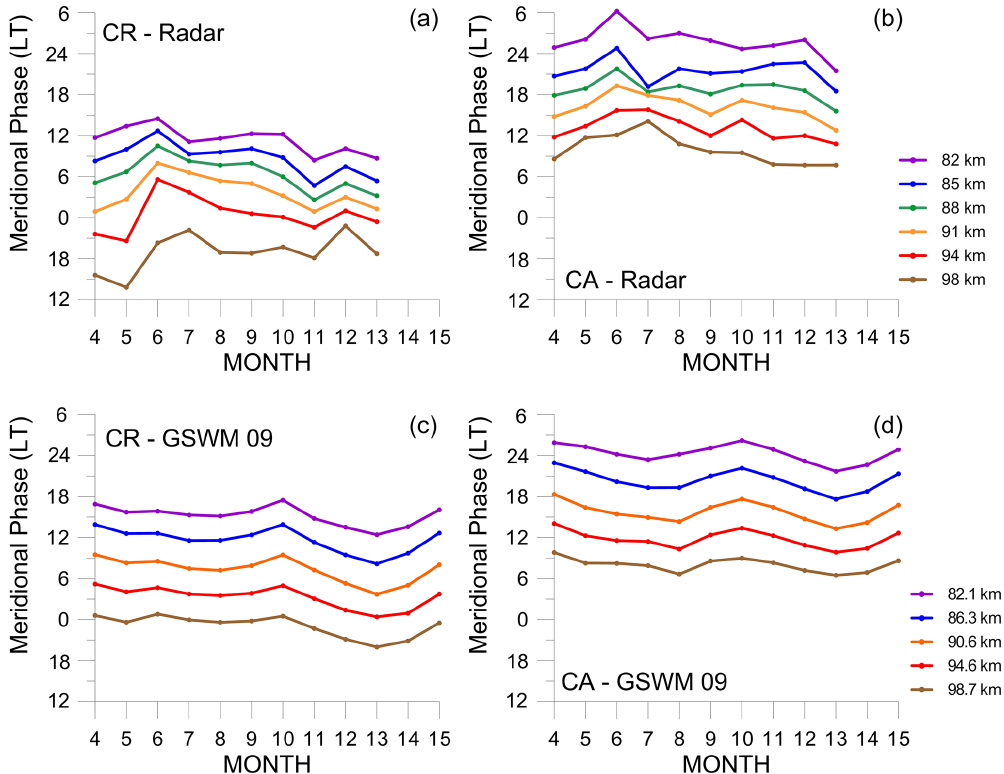
Figure 6. Meridional diurnal phase in LT for CR (a) and CA (b) from April 2005 to January 2006 and GSWM-09 for CR (c) and CA (d) from April to March. The height gates for the radar data and the GSWM-09 data are not quite the same but close enough for visual